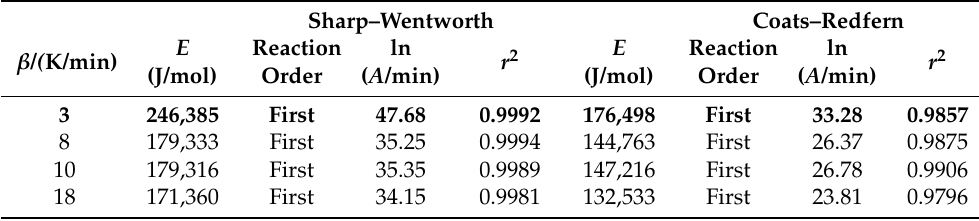
Table 2. The selected temperature ranges of the two reactions.